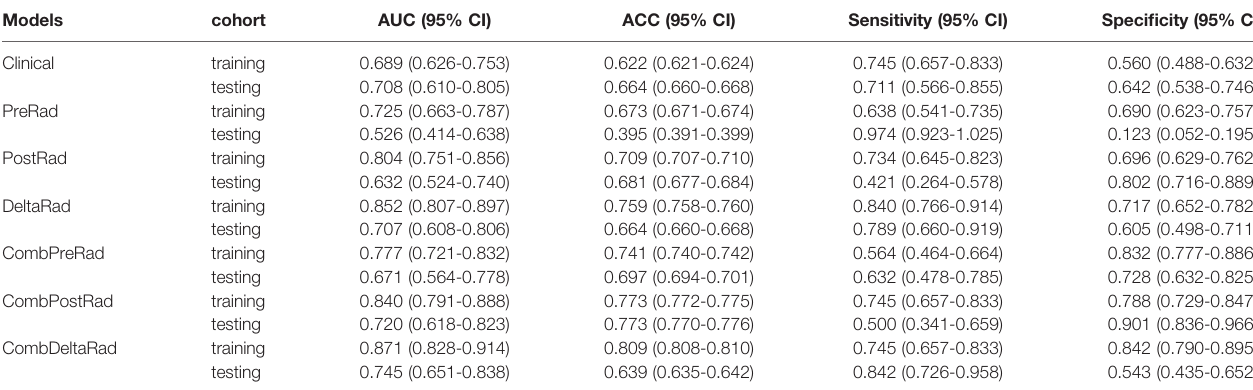
TABLE 3 | 1-year PFS prediction performance of various models.